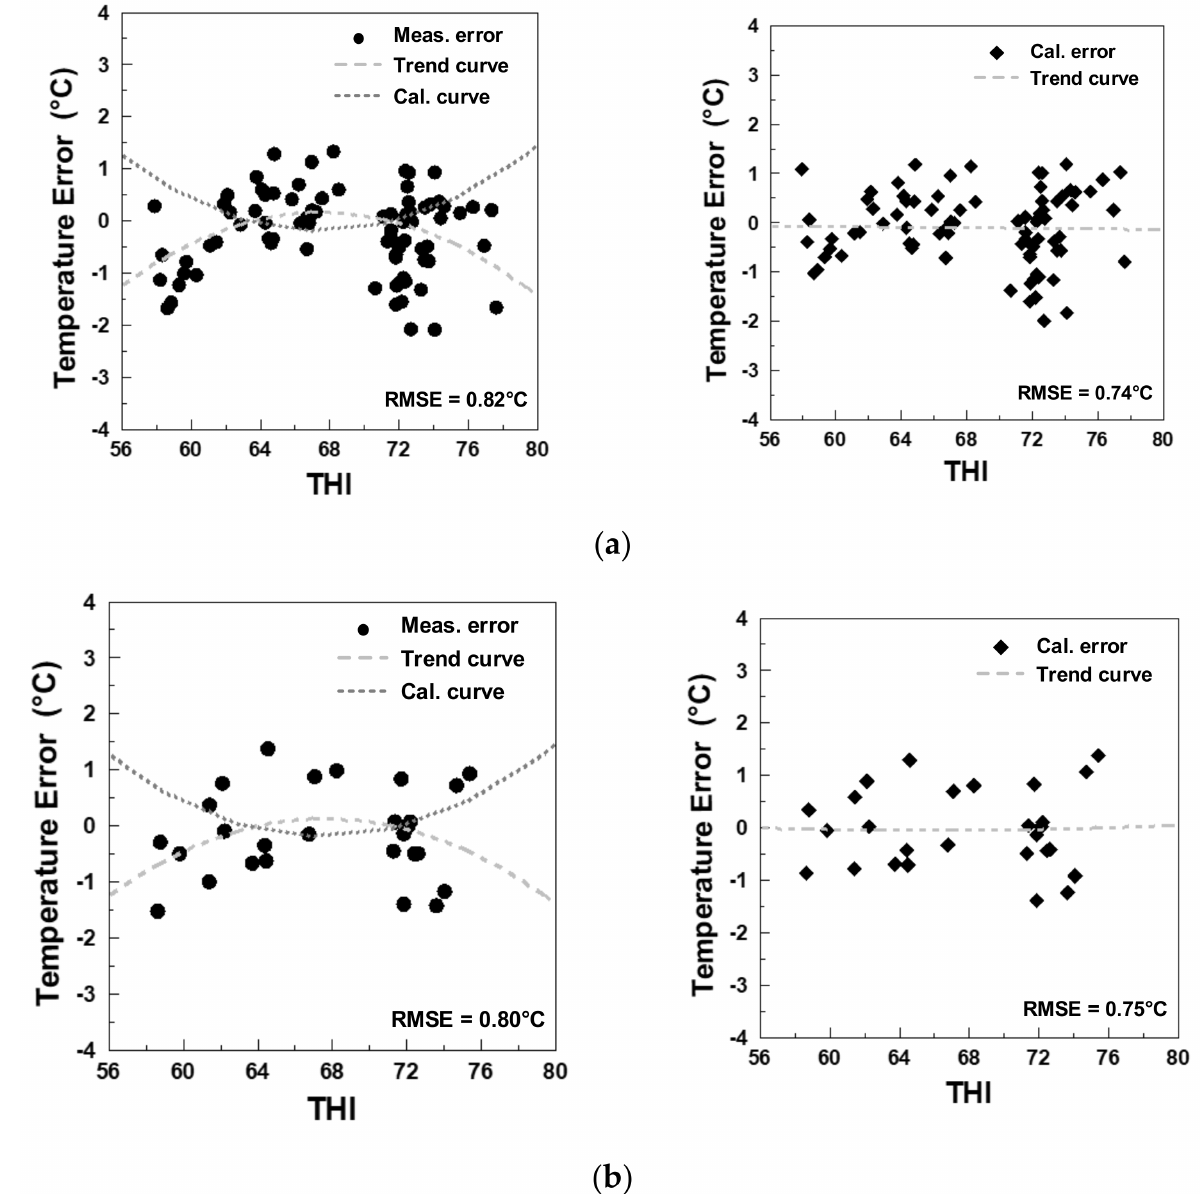
Figure 12. Measured result before and after calibration. ( a ) Training set. ( b ) Testing